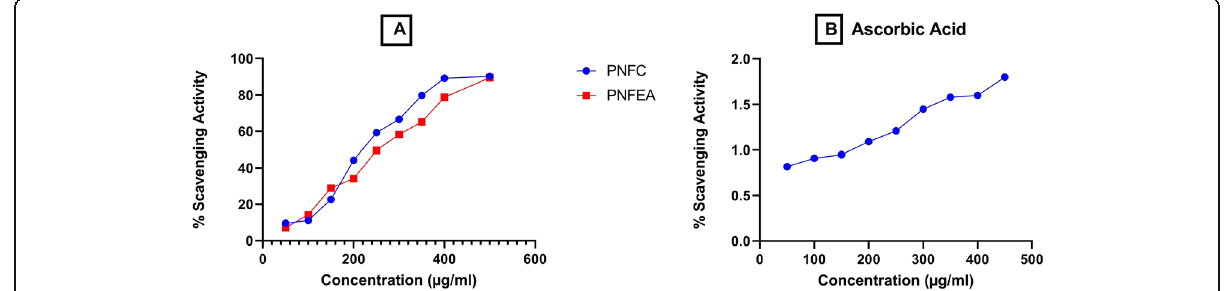
Fig. 6 Reducing power activity of a PNFC and PNFE ( b ) ascorbic